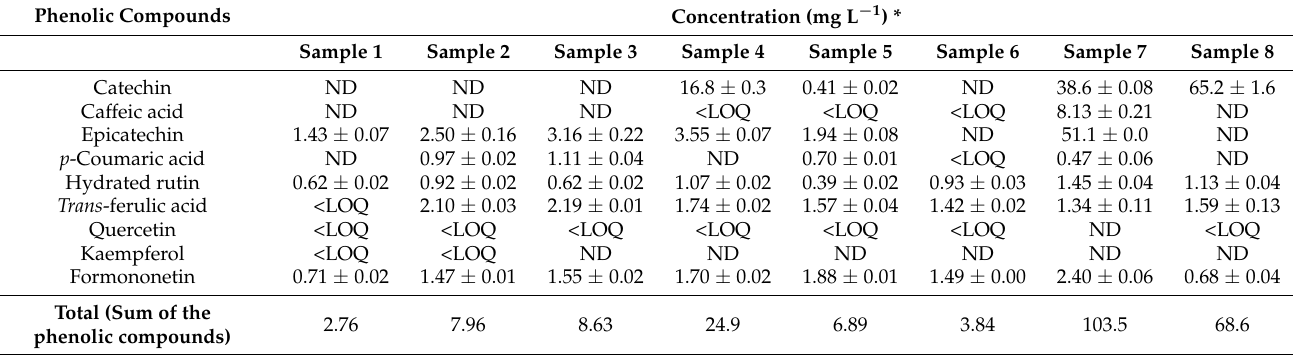
Table 4. Concentration (mg L − 1 ) of the phenolic compounds in Brazilian craft beers samples. Phenolic